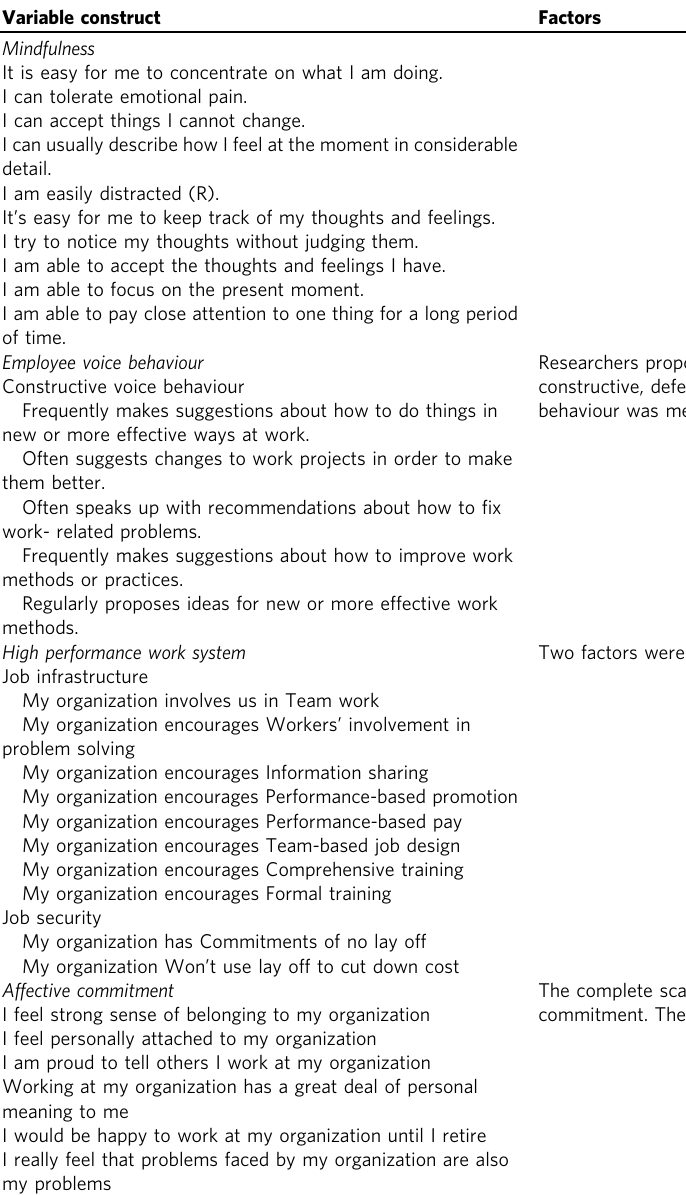
Table 1 Details of questionnaire used for the